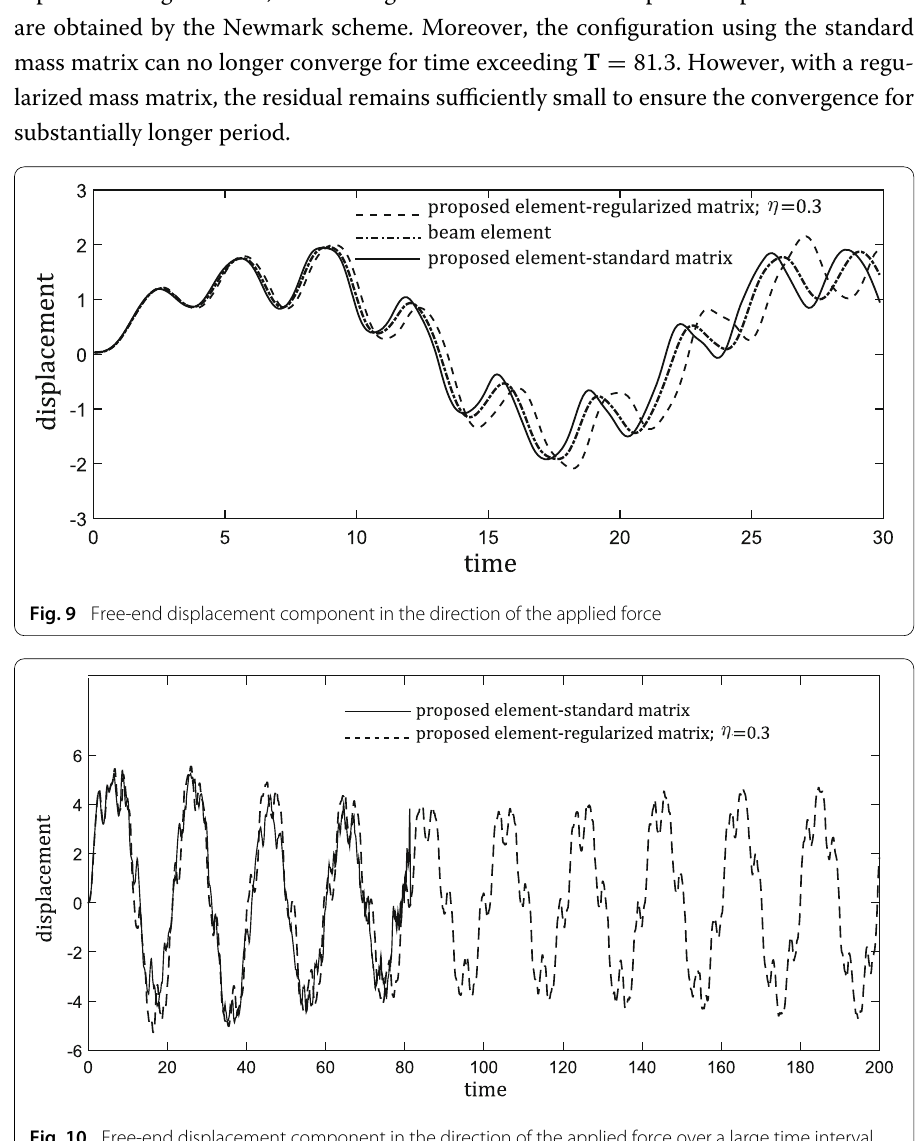
Fig. 10 Free-end displacement component in the direction of the applied force over a large time